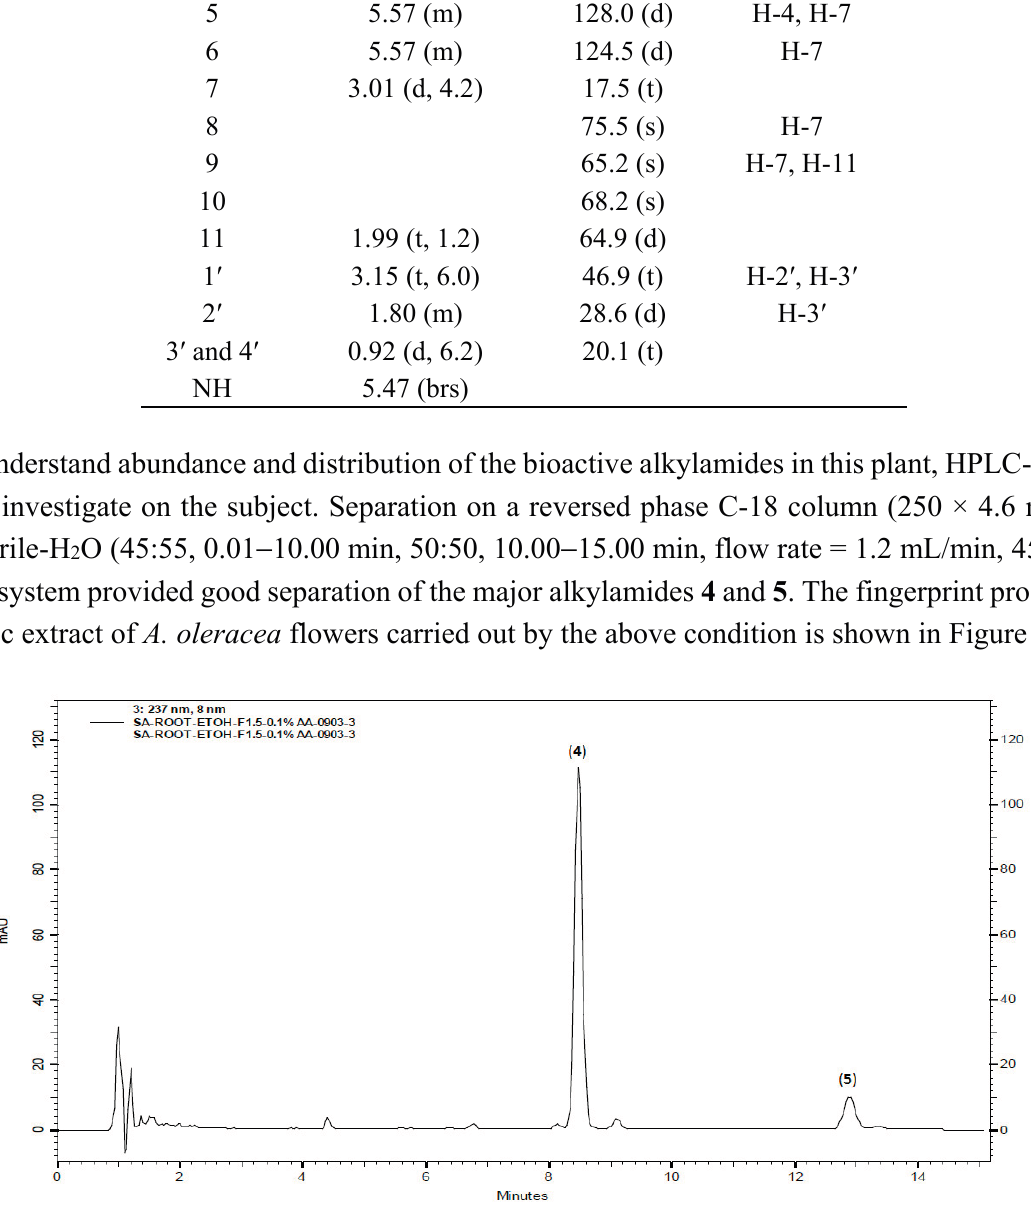
Figure 2. Qualitative HPLC profile of the crude extract of A. oleracea flowers shown the major compounds 4 and 5